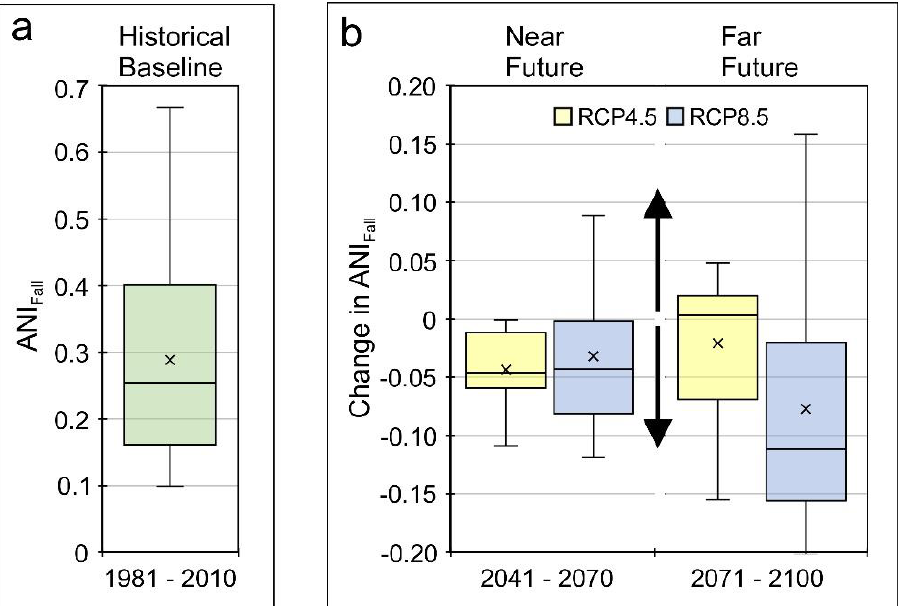
Figure 9. ( a ) Observed Fall Aboriginal Navigation Index (ANI Fall ) for the historical baseline period (1981–2010) and ( b ) simulated projected change in ANI Fall for the near future (2041–2070) and far future (2071–2100) relative to the baseline derived via hydrological model simulations based on 12 sets of climate projections (6 global circulation models × 2 statistically downscaled models) and 2 representative concentration pathways (RCPs 4.5 and 8.5).